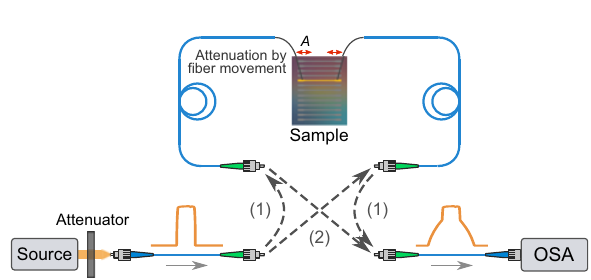
Figure 1. Experimental setup with the typical input and output spectra, and the fibre connections used to perform bi-directional measurements. The source is composed of an erbium-doped fibre laser followed by a grating based pulse